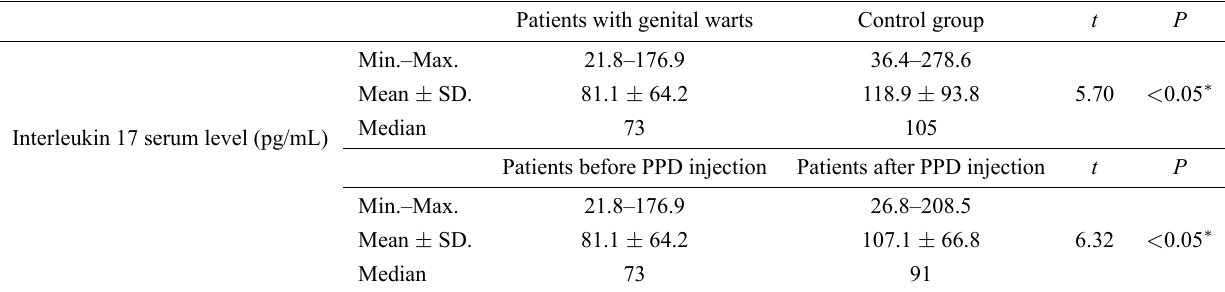
Table 4. Comparison between patients and control groups according to IL-17 serum level (pg/mL).